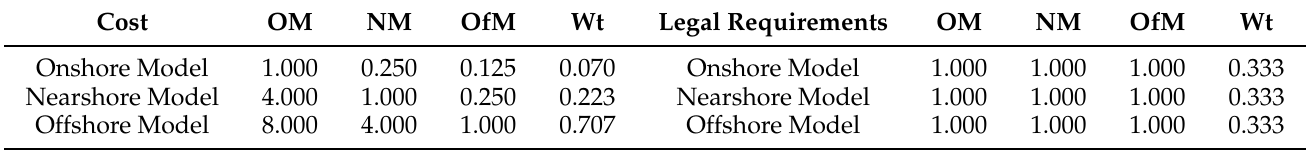
Table A3. Case study-2: Calculation of alternative preferences with respect to costs and legal requirements.